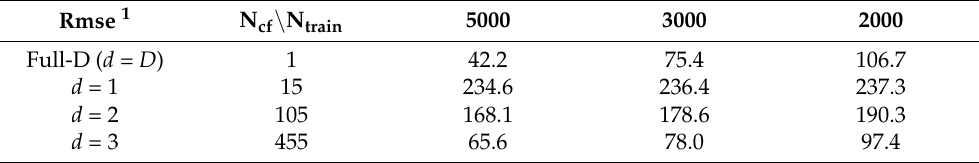
Table 1. Test set root mean square error (rmse) when fitting the potential energy surface of UF 6 with HDMR-GPR of different orders d for different numbers of training points N train . For comparison, the results with a full 15-dimensional GPR are also shown. The numbers of component functions N cf at each d are also